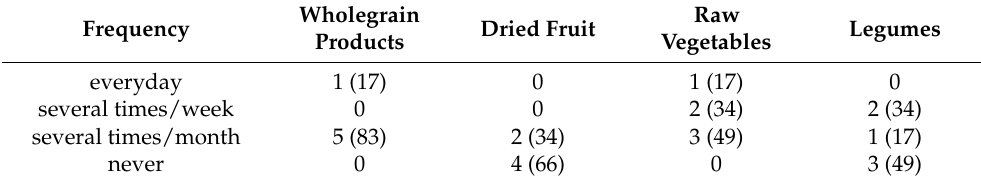
Table 5. Frequency of consumption of selected food groups in